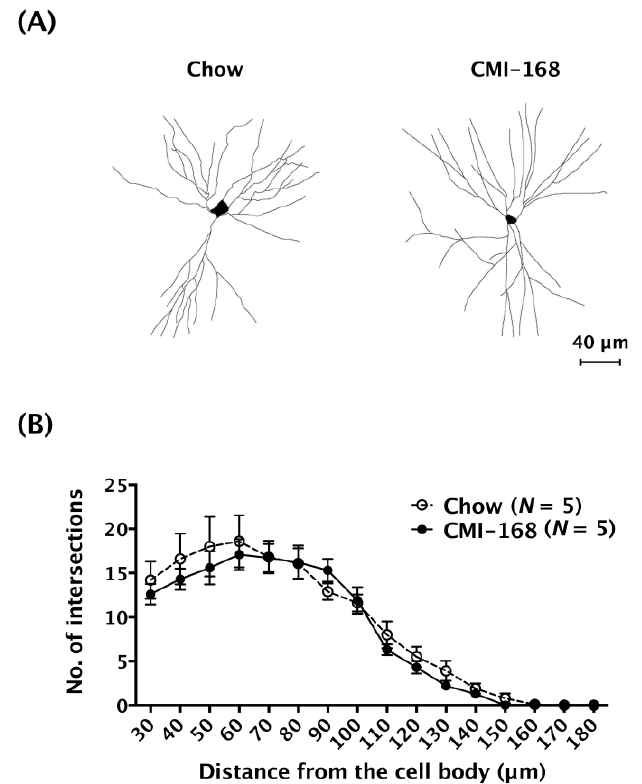
Figure 5. Effects of six-week CMI-168 dietary supplementation on the dendritic complexity of CA1 pyramidal neurons in mice. ( A ) Representative micrographs of the dendritic arborization of CA1 neurons of the Chow and CMI-168 mice. ( B ) Morphometric results of Sholl analysis from the CA1 neurons of the Chow and CMI-168 mice.